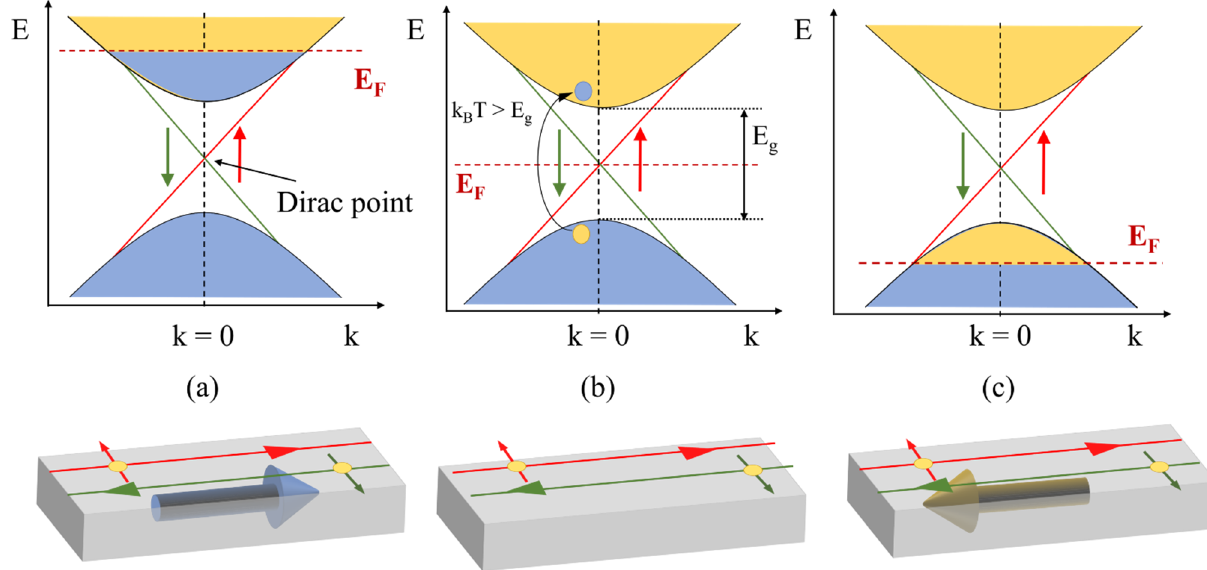
Figure 2. Schemes showing the band structure and the different contributions to transport in TIs: ( a ) n-type conduction with parallel contributions of the surface and the bulk. ( b ) Topological regime with pure surface transport, also indicating the possibility of bulk presence due to thermal activation. ( c ) p-type conduction with surface and bulk contributing. Blue and yellow regions in the bands indicate electron and hole populations, respectively.